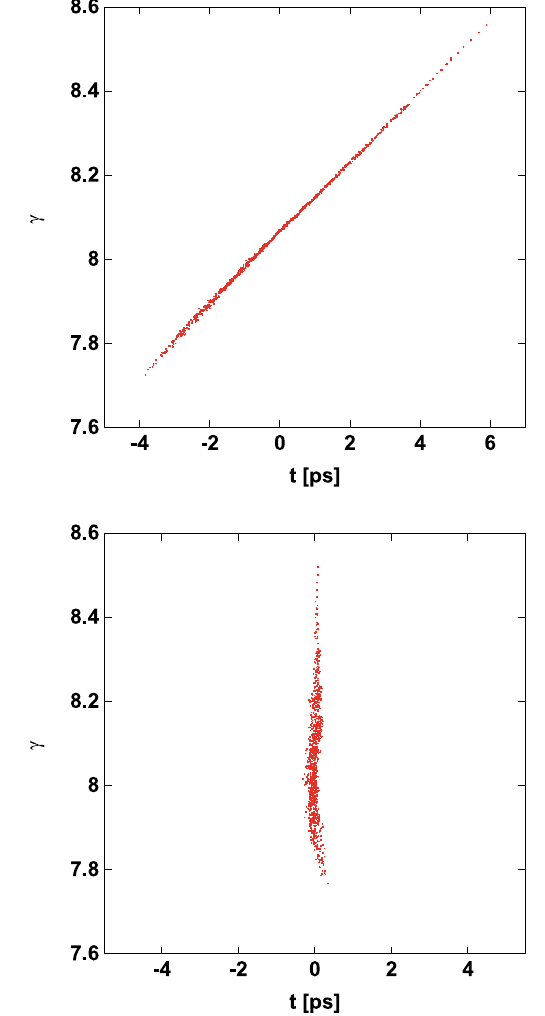
FIG. 7 (color online). Phase space distribution at the output of ECC-rf gun (top) and most compressed point (bottom) calculated by GPT.